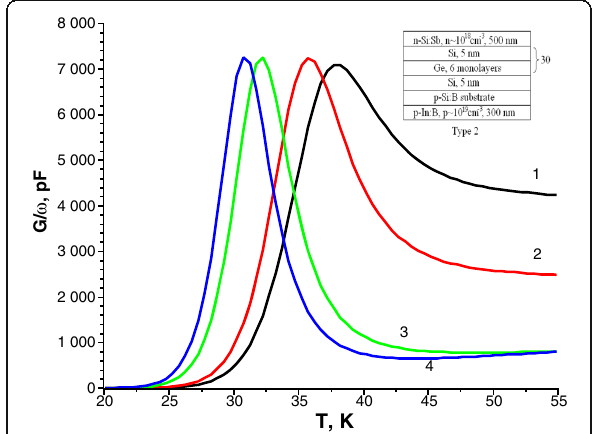
Fig. 2 Temperature spectra of conductance for sample type 2 measured at the applied bias voltage of – 0.5 V and various frequencies of the test signal 1 100 kHz, 2 50 kHz, 3 10 kHz, and 4 5 kHz. The inset shows the structure of